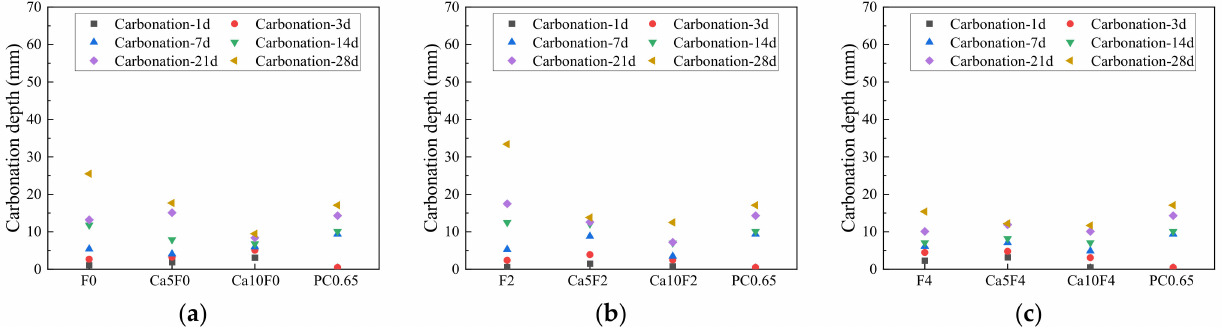
Figure 3. Evolution law of carbonization depth between geopolymers and cement. ( a ) F0; ( b ) F2; ( c ) F4.